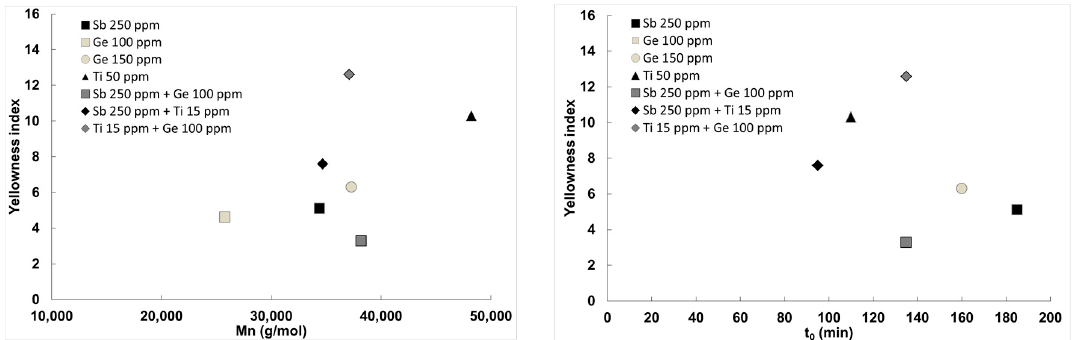
Figure 3. Yellowness index as a function of the number-average molecular weight ( left ) and t 0 ( right ).